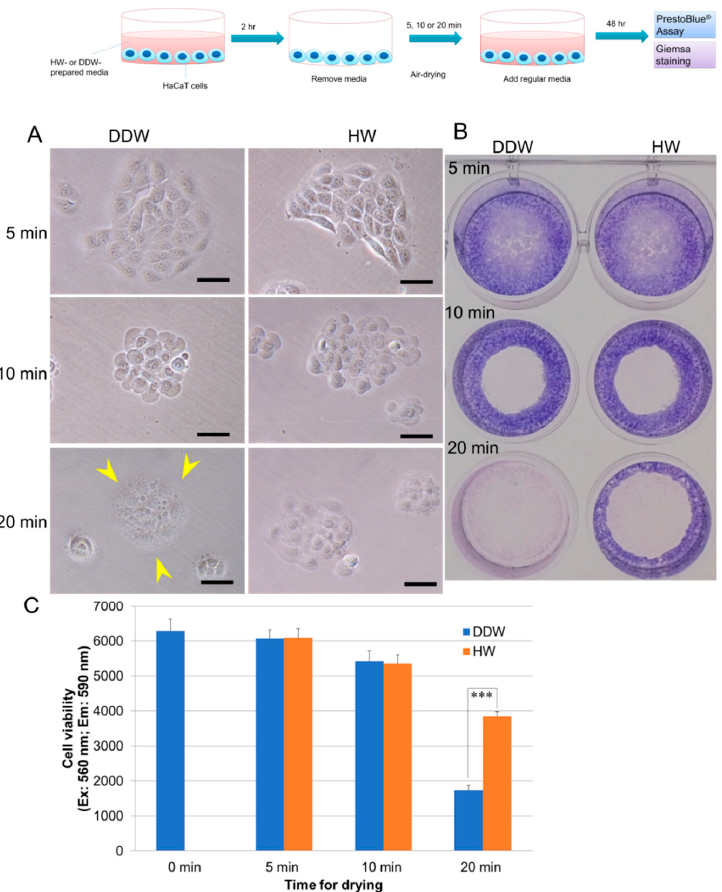
Figure 1. Effects of hydrogen-rich water (HW) on hypohydration-induced cell death in human skin keratinocytes HaCaT. HaCaT cells (2 × 10 4 cells/well) were seeded into 24-well plates and cultivated for 48 h. Cells were then cultivated in DDW- or HW-prepared medium for 2 h. After the medium was removed, cells were air-dried for 5, 10 and 20 min, and then re-soaked in the regular culture medium. Cells were further cultivated for 48 h and followed by PrestoBlue ® assay and Giemsa staining. Illustration on the top represents procedures of the experiments. ( A ) Typical phase-contrast microscopic images of HaCaT cells immediately after drying. Scale bars = 20 µ m. Cell shrinkage and fragmentation were observed in 20 min dehydrated DDW-pretreated cells, as shown by yellow arrowheads. ( B ) Typical images of HaCaT cells stained by Giemsa solution in a 24-well plate. ( C ) Cell viability of HaCaT cells. ***, p < 0.001. Each bar represents the mean ± SD of three independent